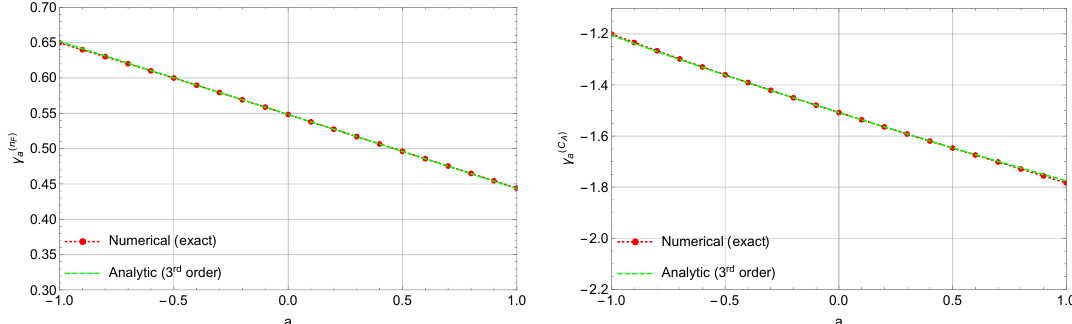
Figure 5 . The functions γ ( n F ) a (left) and γ ( C A ) a (right) as a function of a . The dashed (green) line shows the analytic result based on a third order Taylor expansion, while the points (red) represent the result of the numerical